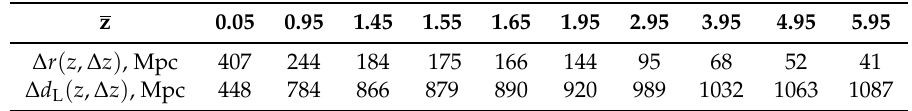
Table 1. The metric size of bins ∆ z = 0.1 in Mpc at various redshifts. ∆ r ( z ) is the size in the moment t = t ( z ) (comoving distances), and ∆ d L is the size in the moment t = t ( 0 ) (proper distances). z 0.05